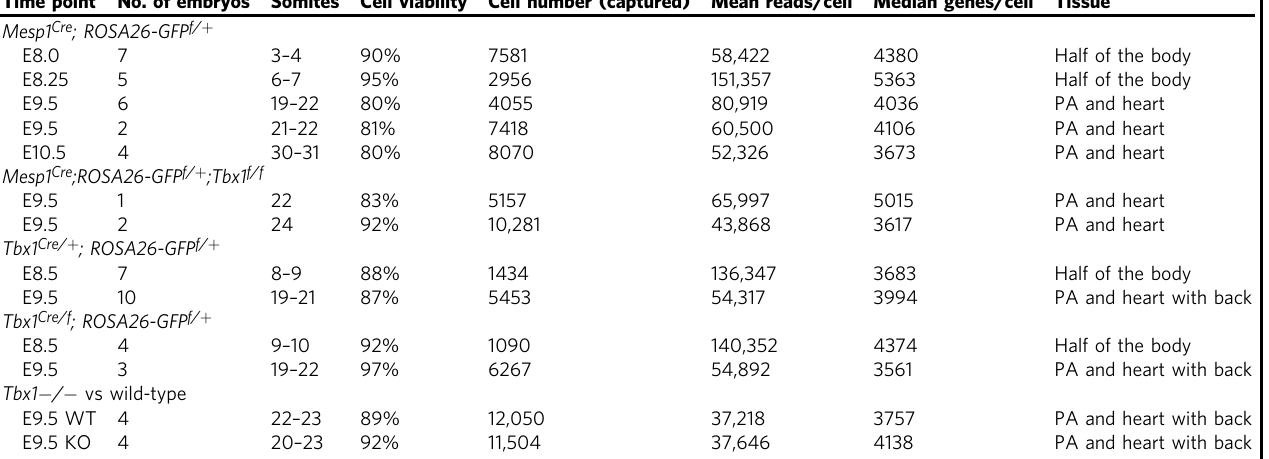
Table 1 Summary of scRNA-seq